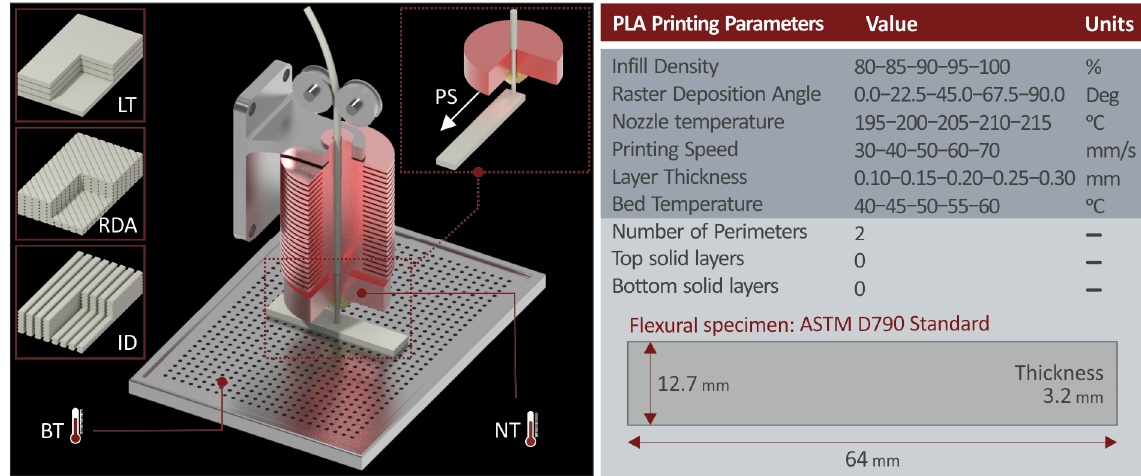
Figure 1. Experimental process ( a ) PLA raw material, ( b ) drying process for the raw material, ( c ) extrusion process for filament production, ( d ) drying of the filament, ( e ) measurements for the en- ergy consumption during the FFF MEX 3D printing process, ( f ) FFF MEX 3D printing, ( g ) tensile experiments, ( h ) SEM images acquisition for the morphological characteristics’ evaluation.